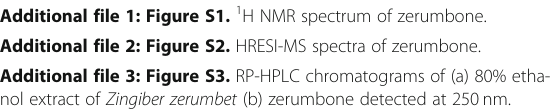
Additional file 1: Figure S1. 1 H NMR spectrum of zerumbone. Additional file 2: Figure S2. HRESI-MS spectra of zerumbone.